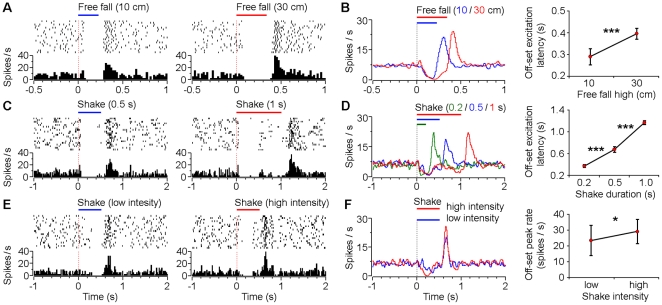
Responses of VTA type-1 putative dopamine neurons to different durations and intensities of fearful events.(A) Peri-event rasters (1–20 trials) and histograms of one example type-1 neuron in response to 10 cm (left) and 30 cm (right) free fall events. (B) Smoothed population average peri-event histograms (left) and offset excitation latencies (right) of type-1 neurons in response to 10 cm (blue line; n = 15) and 30 cm (red line; n = 20) free fall events. (C) Peri-event rasters and histograms of another type-1 neuron in response to 0.5 sec (left) and 1 sec (right) shake events. (D) Smoothed population average peri-event histograms (left) and offset excitation latencies (right) of type-1 neurons in response to 0.2 sec (green line; n = 13), 0.5 sec (blue line; n = 20), and 1 sec (red line; n = 14) shake events. (E) Peri-event rasters and histograms of another type-1 neuron in response to low-(left) and high-intensity (right) shake events. (F) Smoothed population average peri-event histograms (left) and offset excitation peak firing rates (right) of type-1 neurons in response to low- (blue line; n = 9) and high-intensity (red line; n = 9) shake events. Error bars, s.d.; *P<0.05, ***P<10-8, Student's t-test.